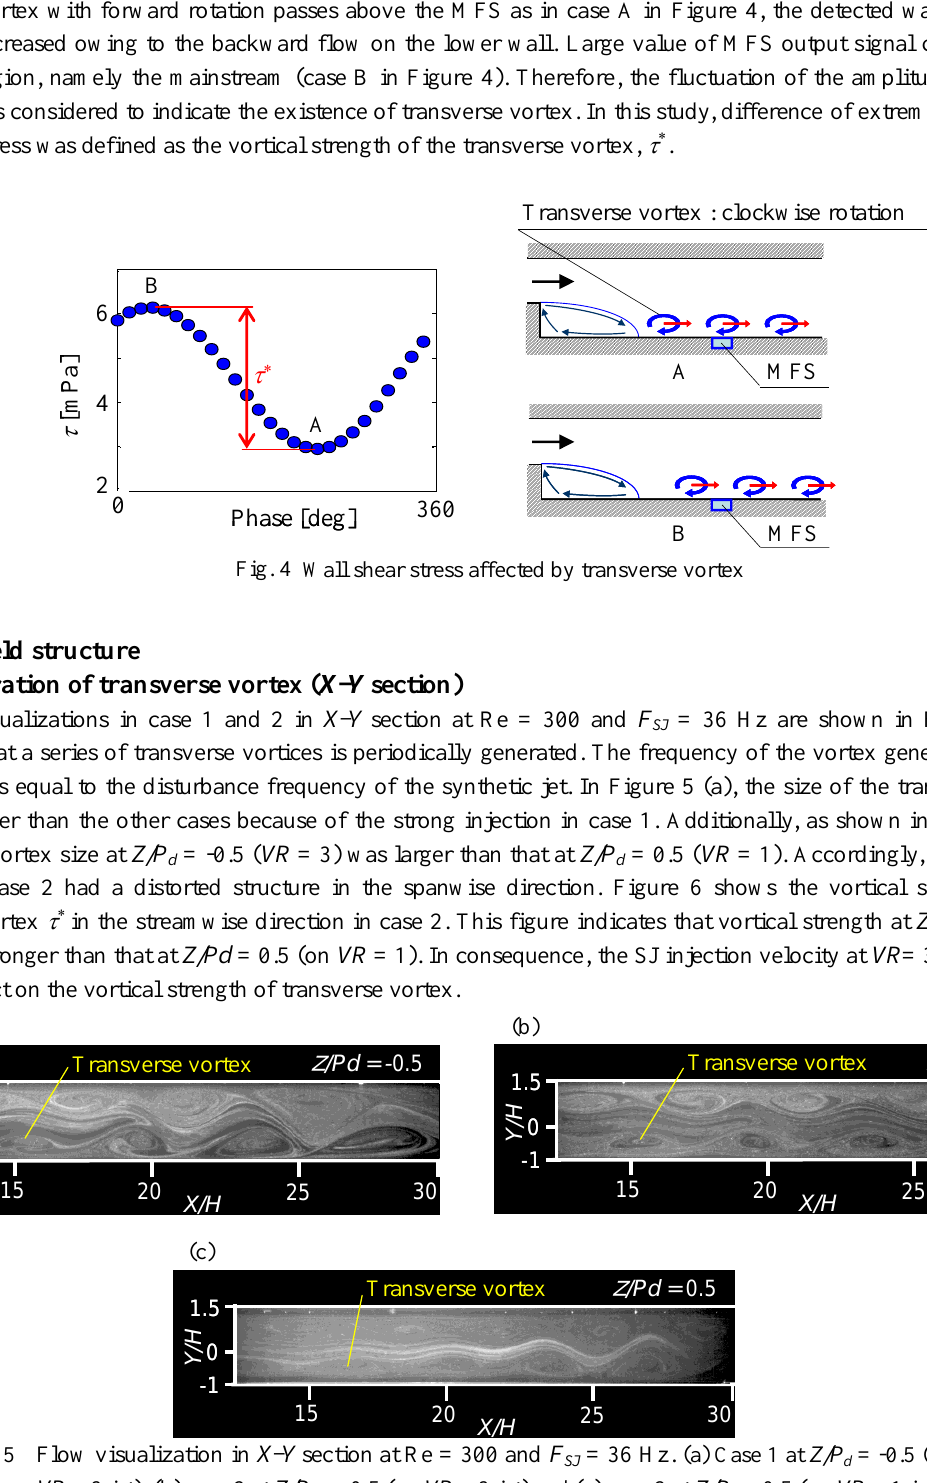
= -0.5 (on VR = 3 jet) and (c) case 2 at Z/P d